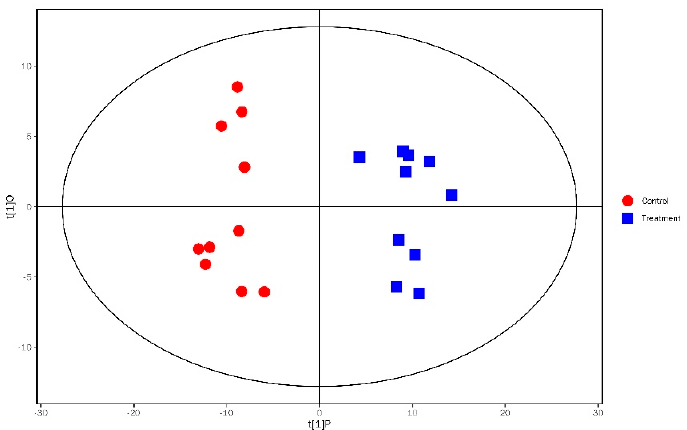
Figure 2. The OPLS-DA model for assessing group differences in the metabolite profiles between A. apis -infected larvae (blue square) and controls (red dot).